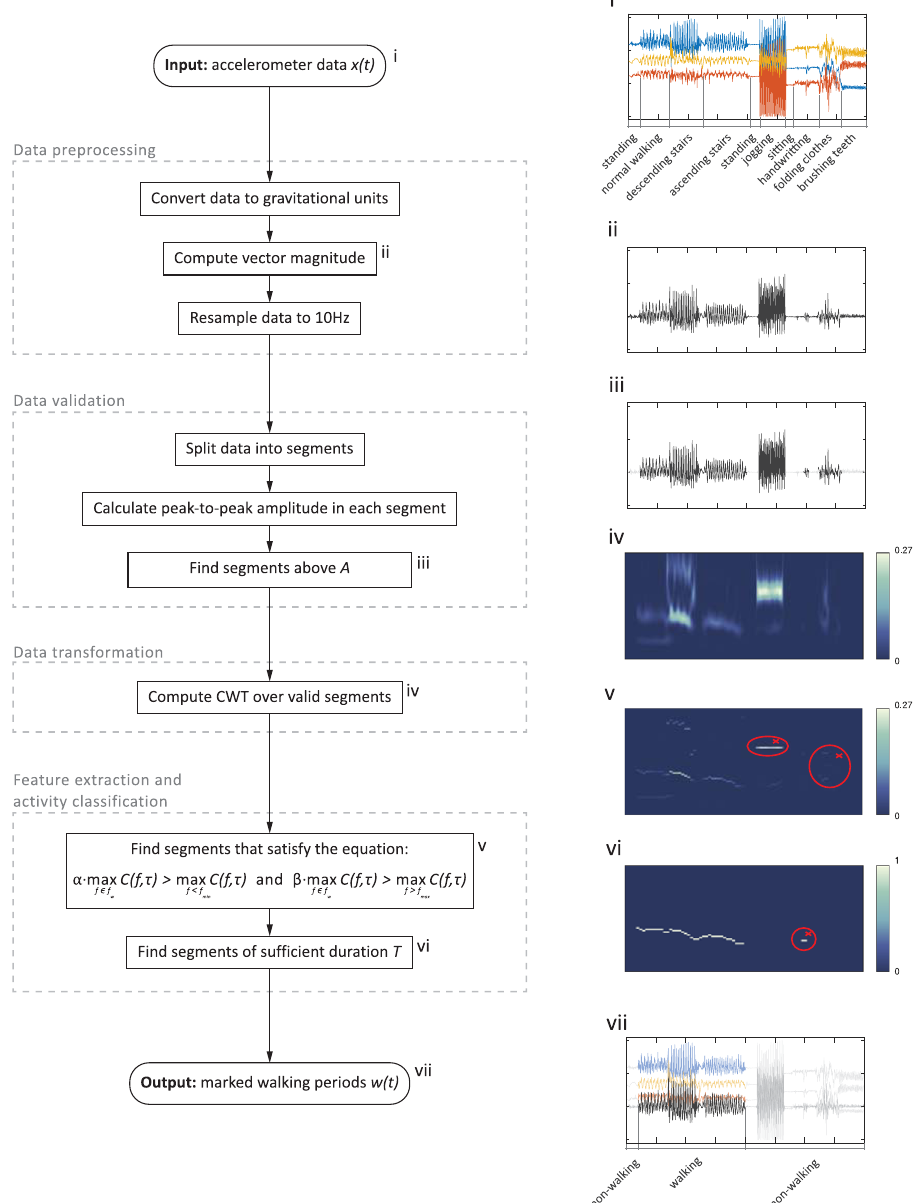
Fig. 3 Walking recognition algorithm and visualization of data processing steps. Walking recognition algorithm consists of four main blocks: data preprocessing block standardizes the input signal (i) to the common format insensitive to temporal sensor orientation (ii), data validation block fi nds high-amplitude data segments (iii), data transformation block reveals frequency of temporal oscillations in time (iv), feature extraction and activity classi fi cation block excludes segments with important frequency components outside f w (v), as well as segments of insuf fi cient duration (vi), and returns the output signal with marked walking (vii). Selected algorithm steps are visualized using example data collected with a smartwatch placed on a wrist ( WISDM dataset 59